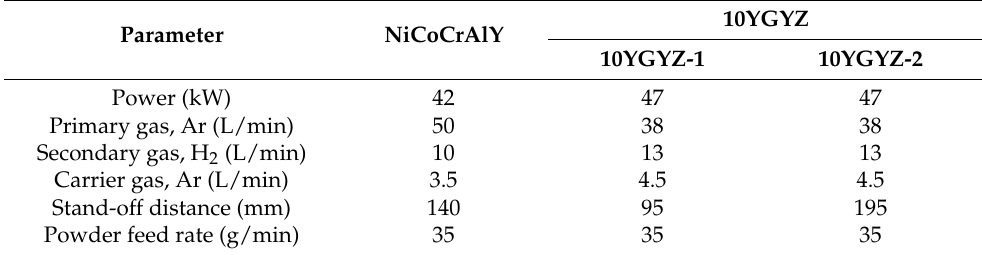
Table 1. APS parameters for 10YGYZ